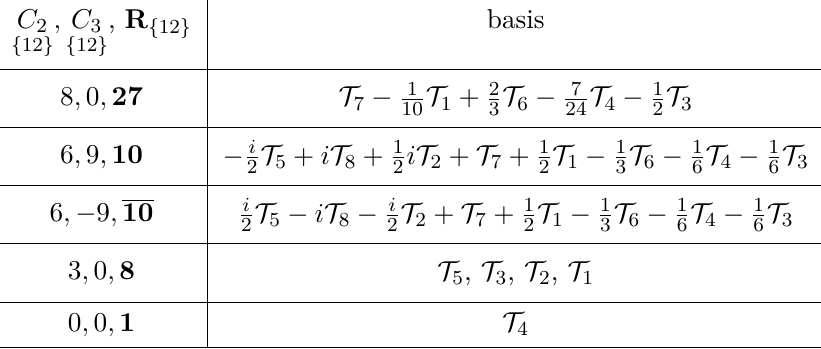
Table 8 . Gauge partial-wave basis of SU(3) particles { 8 , 8 , 8 , 8 } of partition { 12 | 34 }